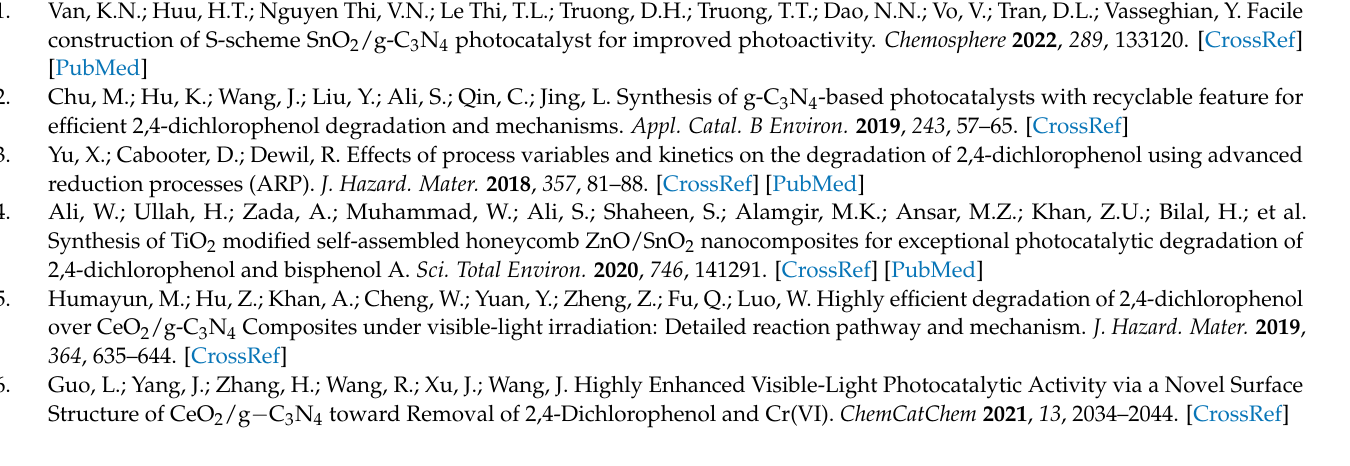
Figure S2: (a) XRD patterns and (b) DRS spectra of FO, 5SO/FO, and 2Ag-5SO/FO, respectively.; Figure S3: TEM images of (a) FO, (b) SO, and (c) 5SO/FO, respectively.; Figure S4: FS spectra related to • OH radical of (a) FO, x SO/FO, and (b) y Ag-5SO/FO.; Figure S5: EIS Nyquist plots related to charge separation of (a) FO, x SO/FO, and (b) y Ag-5SO/FO.; Figure S6: Photocatalytic activities for 2,4-DCP degradation of FO, 5SO/FO, and 2Ag-5SO/FO, respectively, under visible-light irradiation in the presence of different scavengers. Ethylenediamine tetra-acetic acid disodium salt (EDTA-2Na) is the scavenger for the photogenerated (h + ), isopropyl alcohol (IPA) for ( • OH) and benzoquinone (BQ) for • O 2- , respectively.; Figure S7: Photocatalytic aerobic degradation for BPA over (a) FO, x SO/FO, and (b) y Ag-5SO/FO samples under visible-light irradiation.; Figure S8: Photocatalytic aerobic degradation for MO over (a) FO, x SO/FO, and (b) y Ag-5SO/FO samples under visible-light